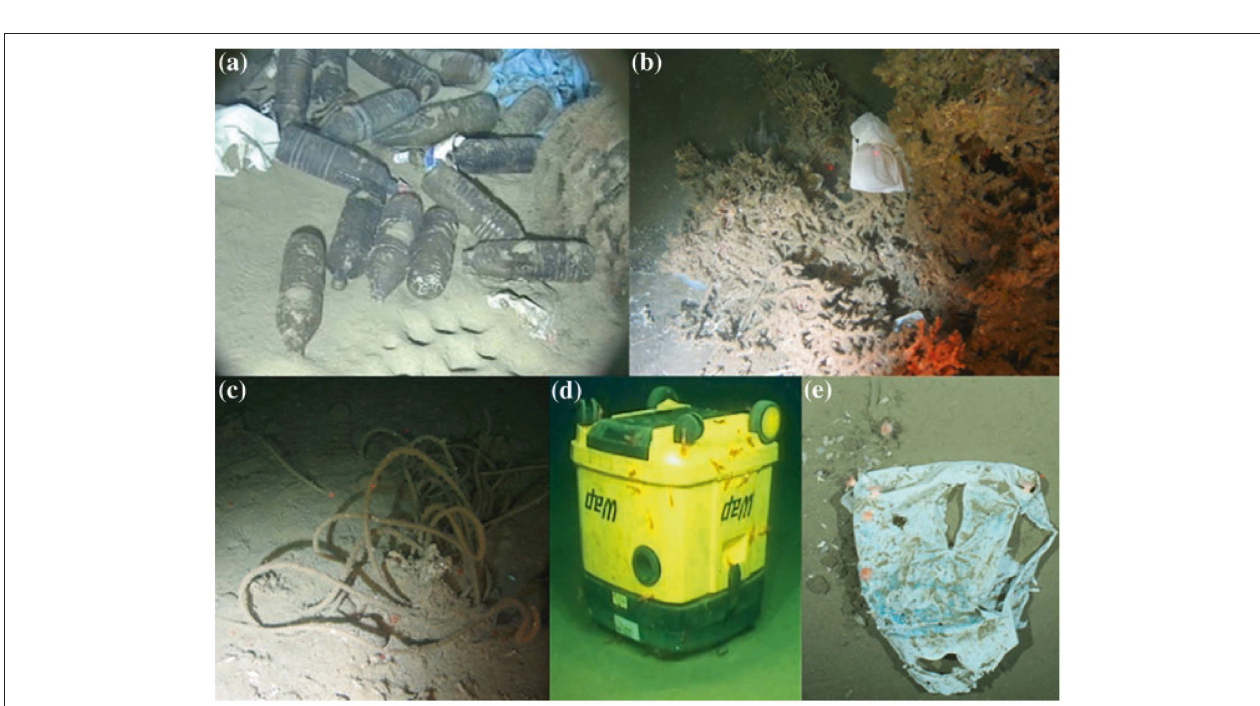
FIGURE 4 | Litter on the deep seafloor. (a) Plastic bags and bottles dumped 20km off the French Mediterranean coast at 1,000m in close vicinity to burrow holes; (b) food package entrapped at 1,058m in deep-water coral colony; (c) rope at 1,041m depth, both from Darwin Mounds; (d) waste disposal bin or a vacuum cleaner with prawns on the seafloor off Mauritania at 1,312m depth; (e) plastic carrier bag found at ∼ 2,500m depth at the HAUSGARTEN observatory (Arctic) colonized by hormathiid anemones and surrounded by dead tests of irregular sea urchins (adopted from Galgani et al., 2015 Galgani holds copyright of this